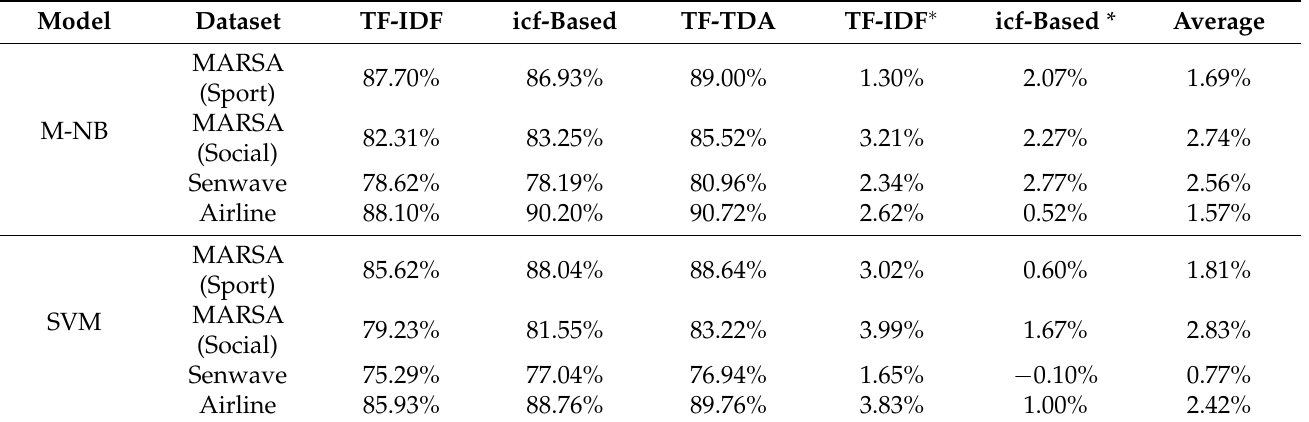
Table 9. F1 score for all